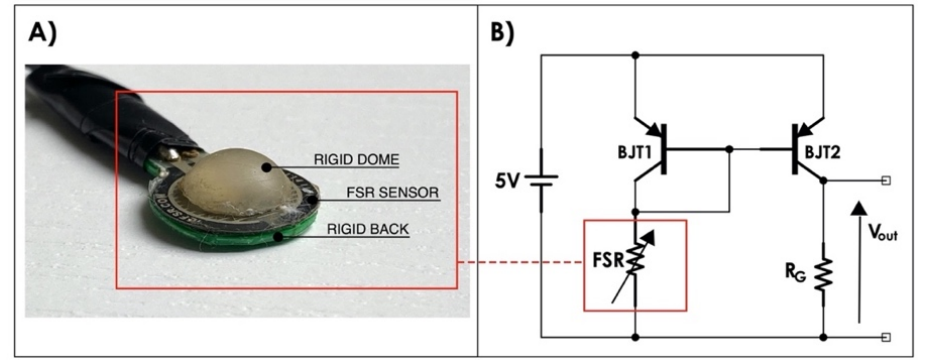
Figure 6. ( A ) A picture of an FSR-based sensor equipped with a custom mechanical coupler; ( B ) FSR conditioning circuit, based on current mirror (R G = 910 Ω